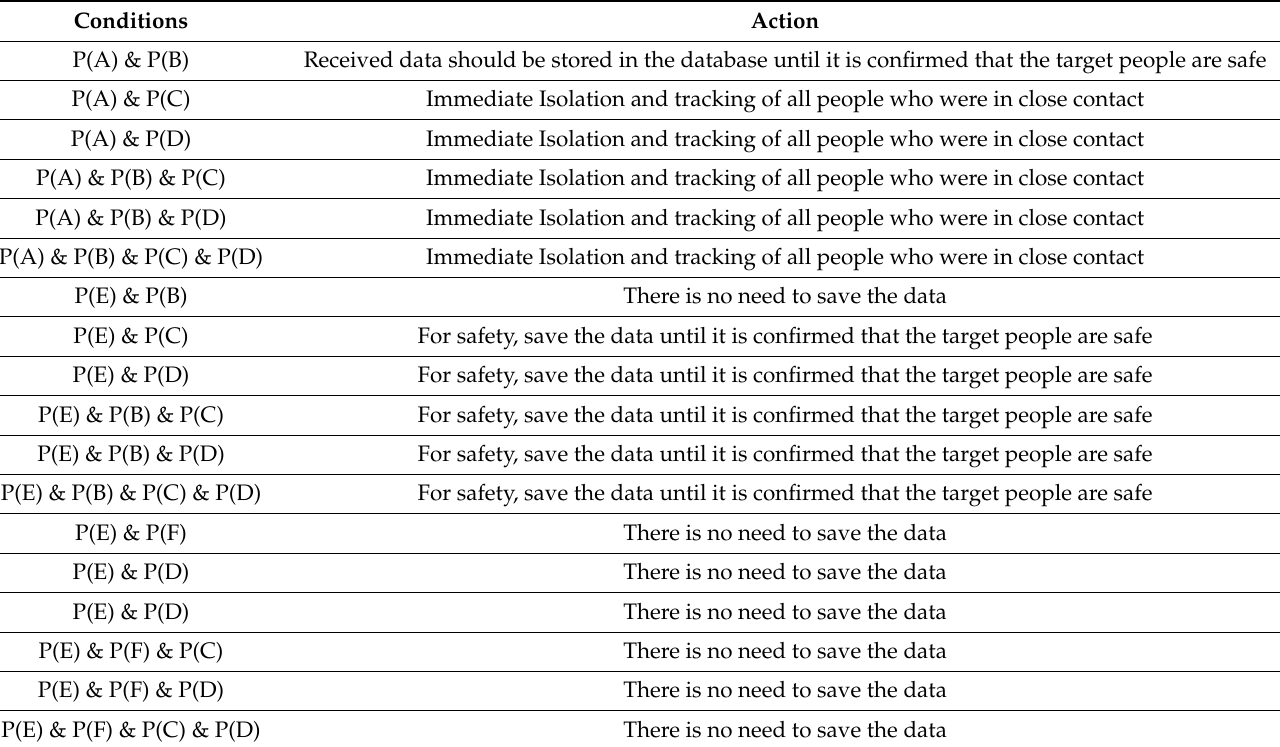
Table 1. Example of COVID-tracking actions based on the received